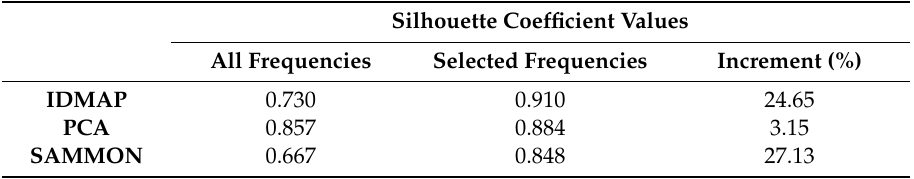
Table 1. Silhouette coefficient values for all multidimensional projection data.